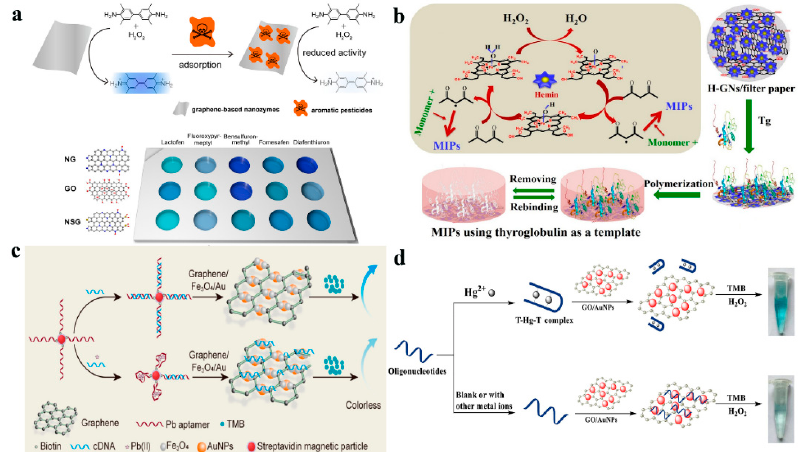
Figure 1. ( a ) Nanozyme sensor arrays based on heteroatom-doped graphene for detecting pesticides. Reprinted with permission from Ref. [28]. Copyright 2020 ACS; ( b ) The fabrication principle of